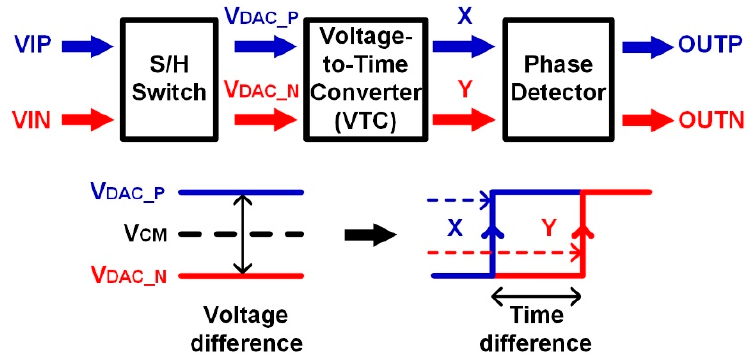
Figure 1. Scheme of a time-domain comparator in ADC.